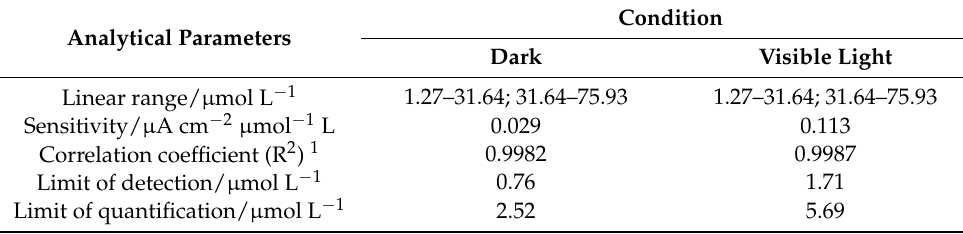
Table 2. Analytical parameters for the voltammetric detection of dopamine using differential pulse voltammetric technique, and the ITO/FeVO(I) electrode obtained by the SILAR process (five layers). Analytical